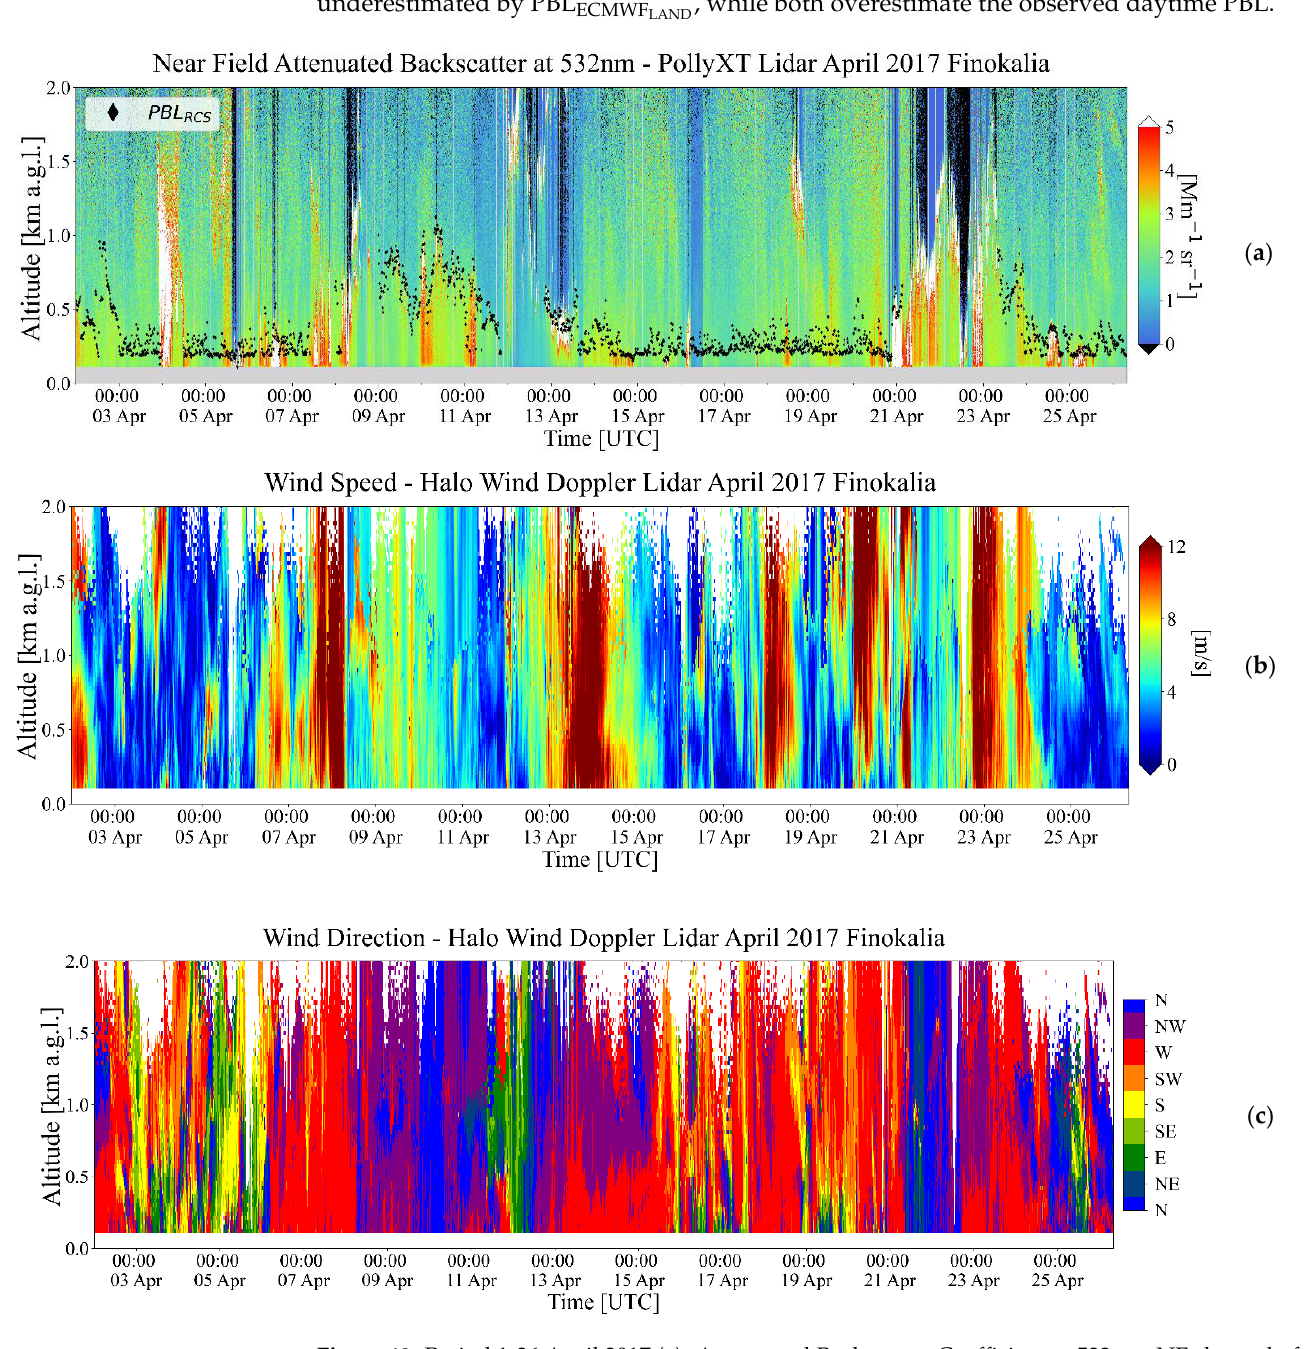
Figure 13. Period 1-26 April 2017 ( a ): Attenuated Backscatter Coefficient at 532 nm NF channel of PollyXT Lidar — PBL height retrieved by WCT on RCS (Black Diamonds), Grey color at the bottom of the Figure, identifies the incomplete overlap of PollyXT Lidar for 532 nm NF channel, ( b ): Wind Speed (m/s) from Halo Wind Doppler Lidar and ( c ): Wind Direction from Halo Wind Doppler Lidar (Bins in colorbar (0°, 22.5°) (22.5°, 67.5°) (67.5°, 112.5°) (112.5°, 157.5°) (157.5°, 202.5°) (202.5°, 247.5°) (247.5°, 292.5°) (292.5°, 337.5°) (337.5°, 360°)).